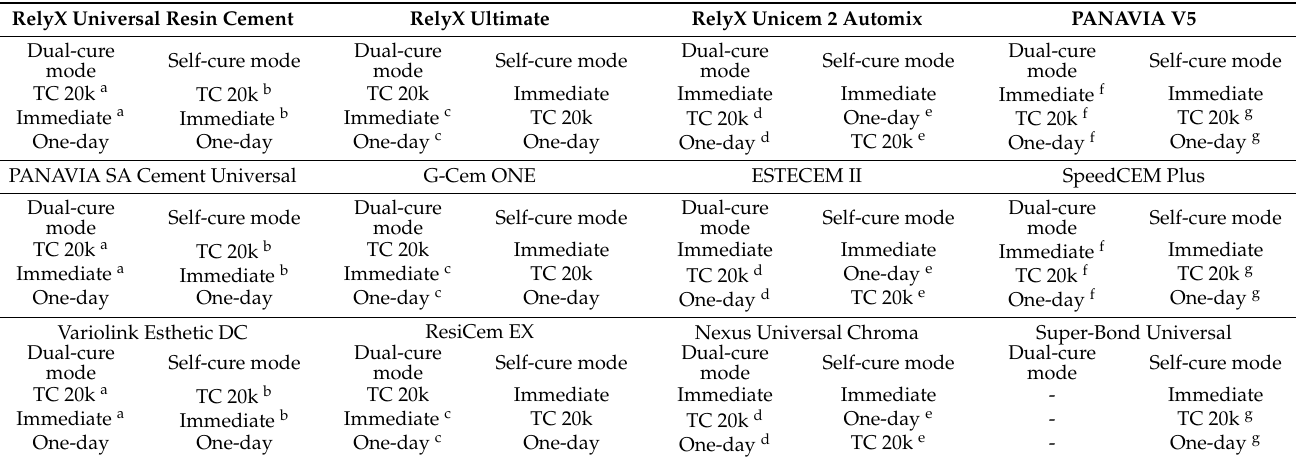
Table 12. Comparison of the means (Tukey HSD procedure) for flexural modulus of each resin cement material with regard to time [superscript letters (a–g) letters represent groups with no significant difference, p >